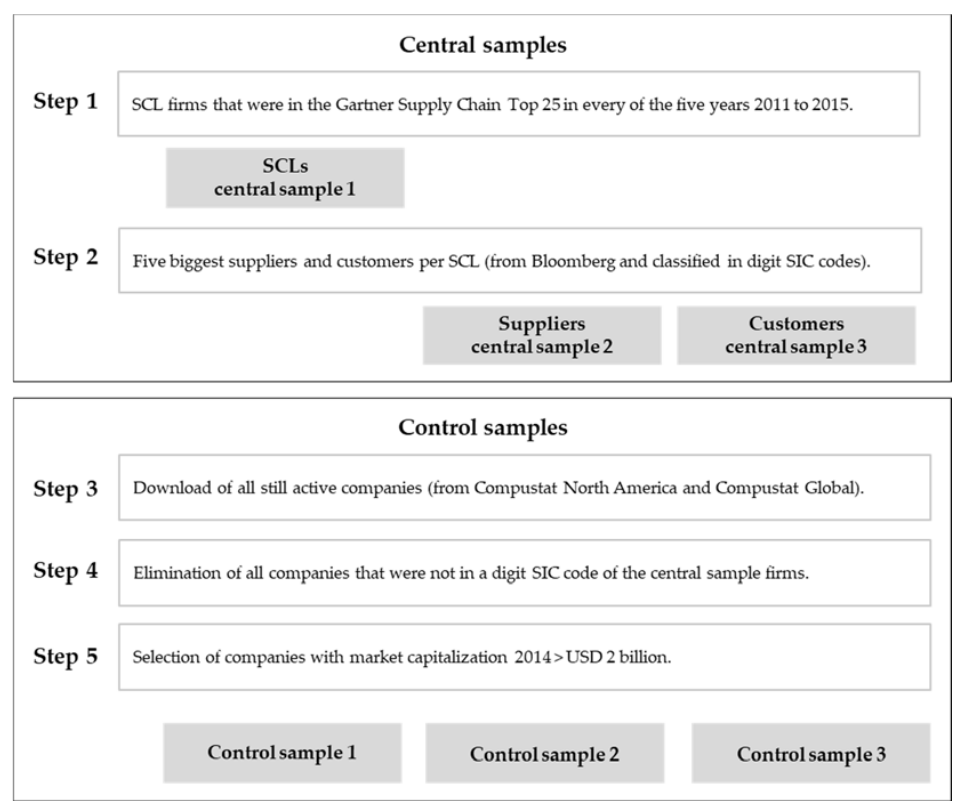
Figure 1. Procedure for selecting the samples.